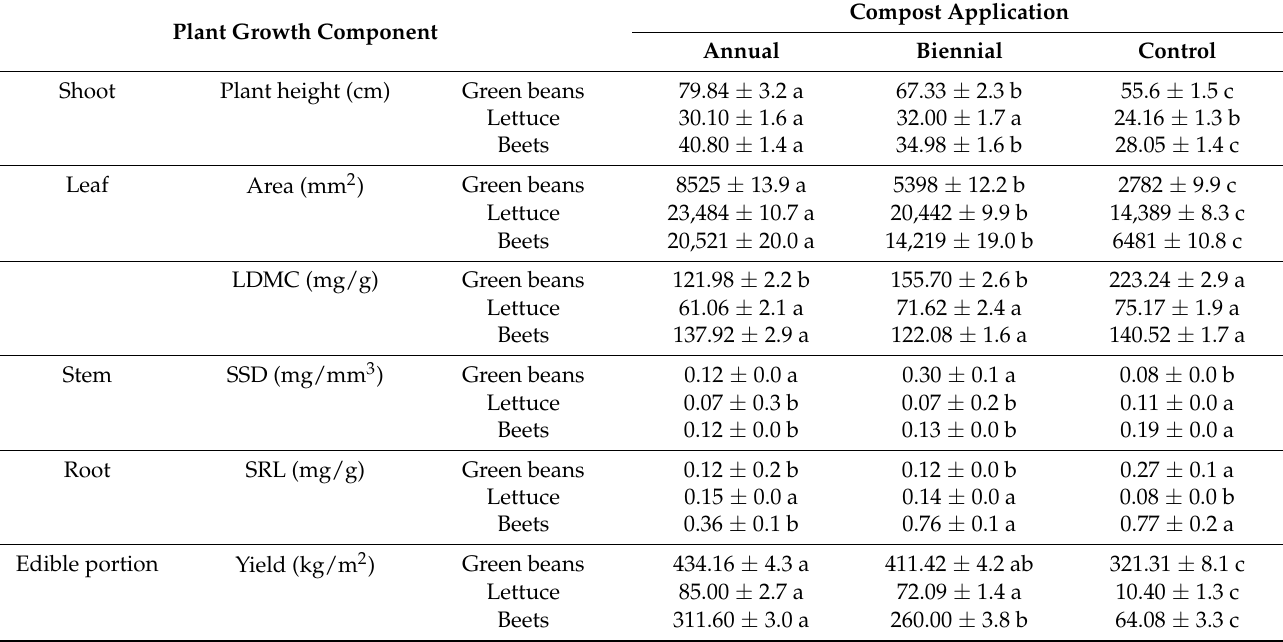
Table 6. Plant growth components and yield of green beans ( Phaseolus vulgaris cv. Golden Wax), beets ( Beta vulgaris cv. Detroit Supreme) and lettuce ( Latuca sativa cv. Grand Rapids) as affected by frequency of application of municipal solid waste